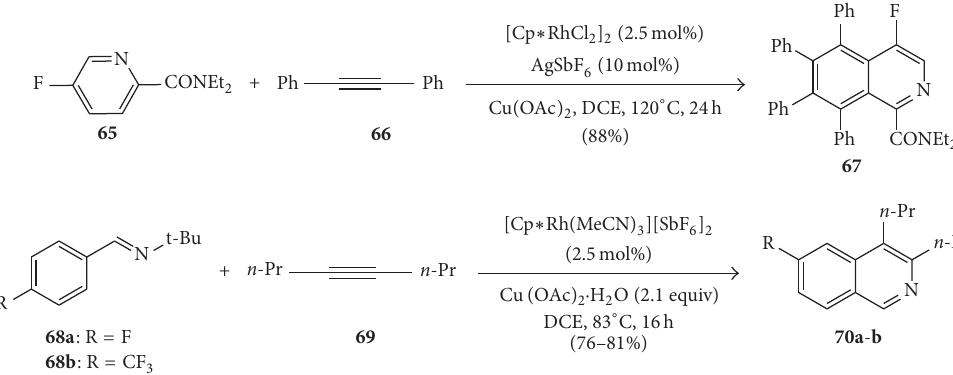
Scheme 16: Rhodium-catalyzed fluoroisoquinoline and trifluoroisoquinoline